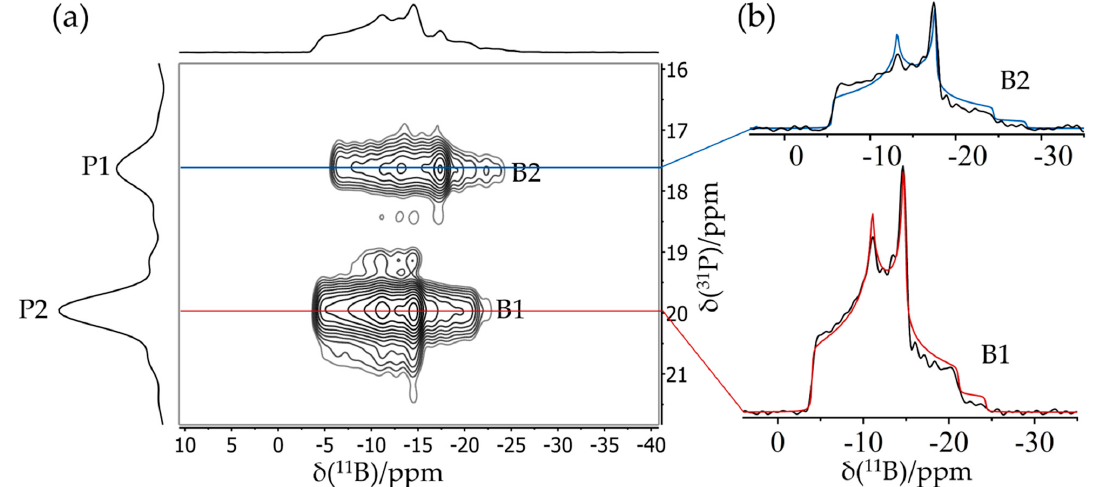
Figure 34. ( a ) 2D 11 B { 31 P} CP / refocused INEPT experiment on 9 . The assignment of boron species results from the covalent bond of P1 in the chair conformation of the six-membered ring with B2 in the boat conformation and vice versa for P2 and B1. ( b ) Horizontal slices of each species (black line) and 11 B line-shape simulations (blue and red